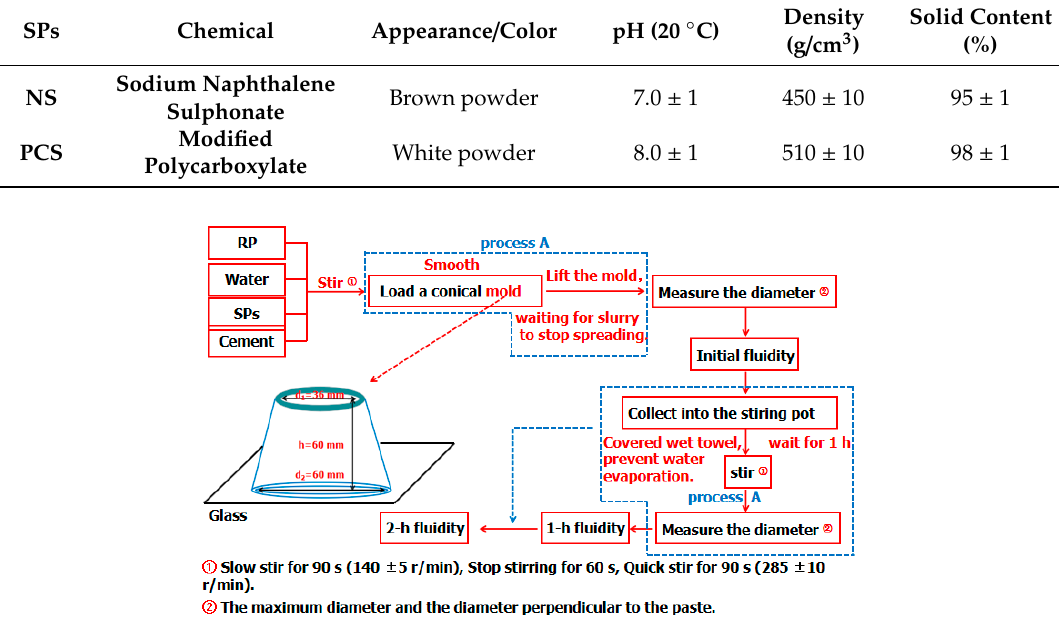
Figure 4. The influence of grinding time on the RP fineness.